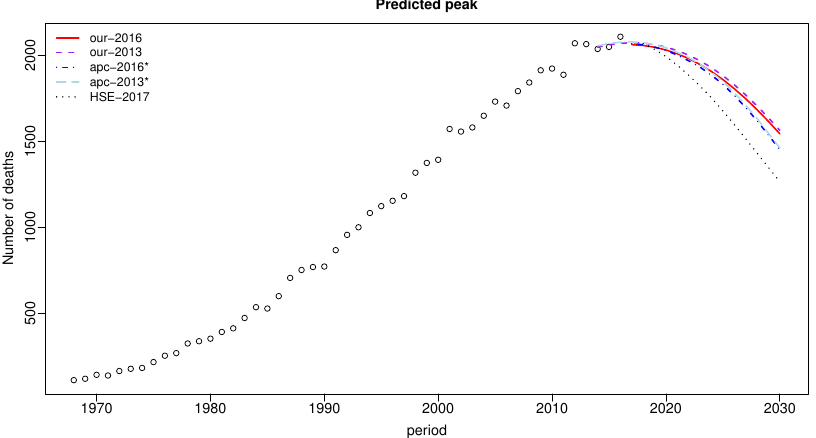
Figure 6. Comparison of forecasts. The observed past numbers of deaths are indicated by dots.